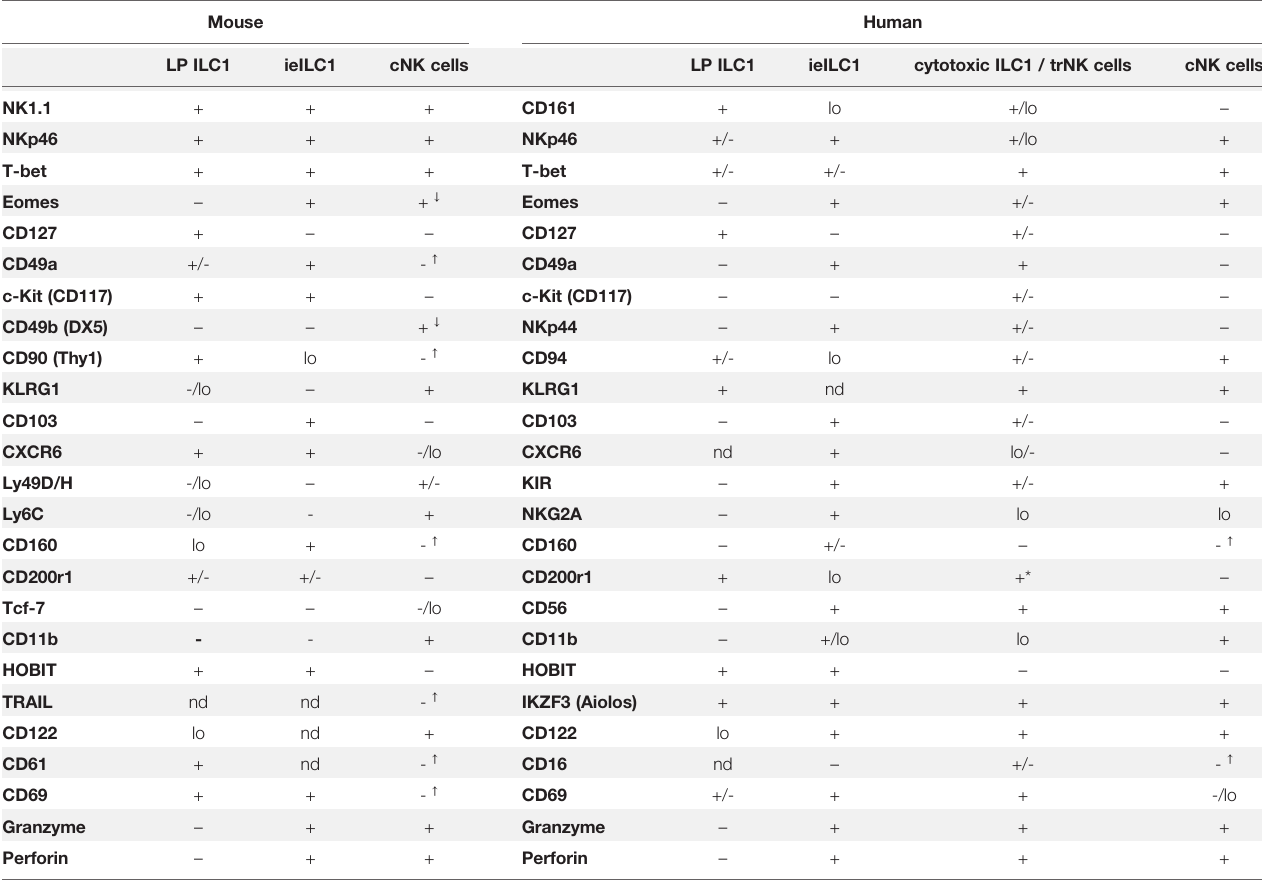
TABLE 1 | NK cell and ILC1